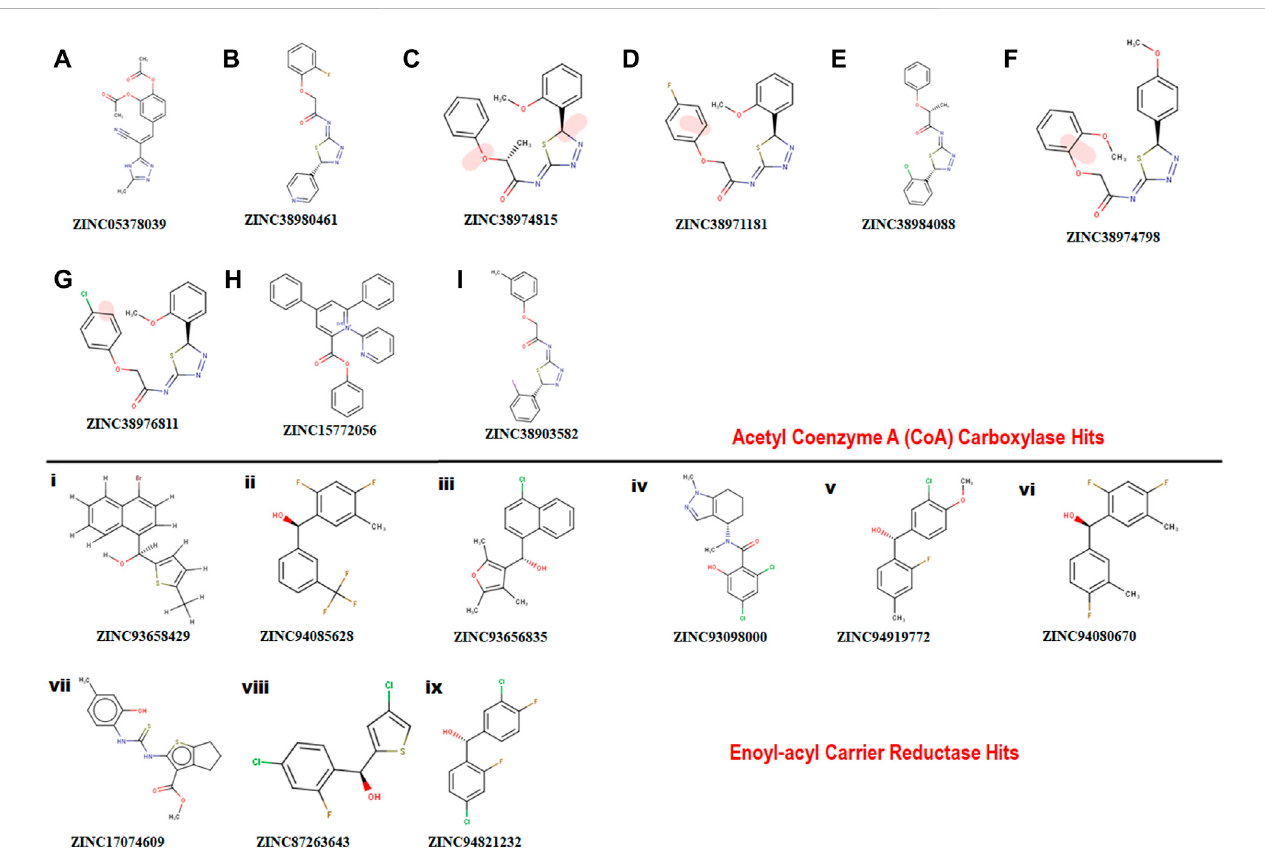
FIGURE 4 A surface view of the binding position of hits at the active sites of (A) Acetyl Coenzyme A Carboxylase and (B) Enoyl-acyl carrier